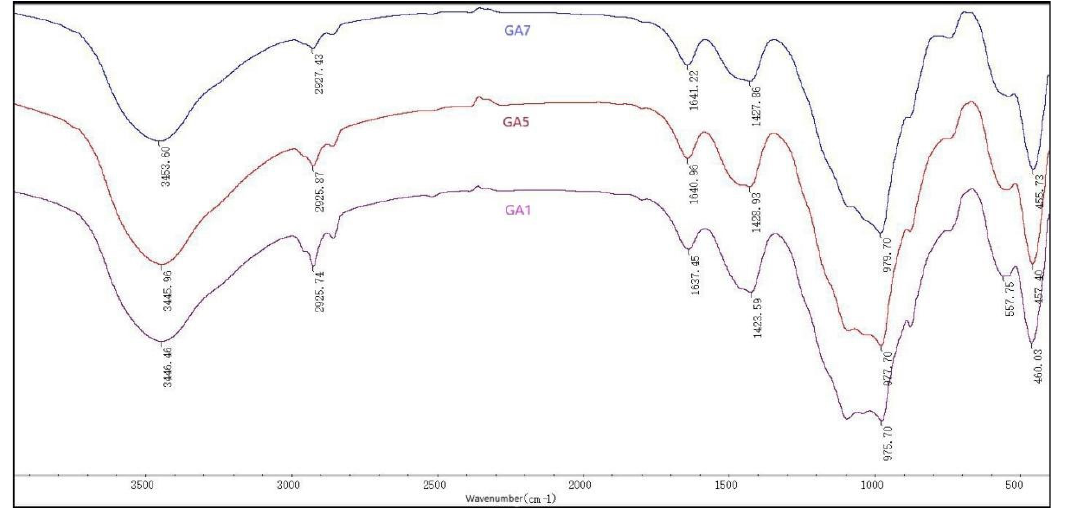
Figure 21. GA paste FT-IR image.